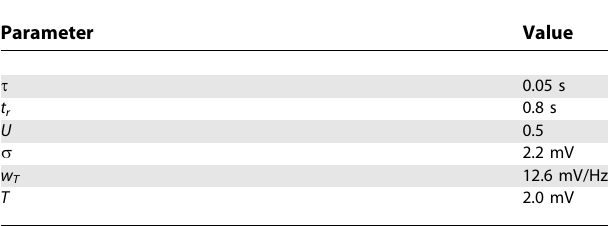
Table 1. Values of Parameters Used in the Simulation Parameter